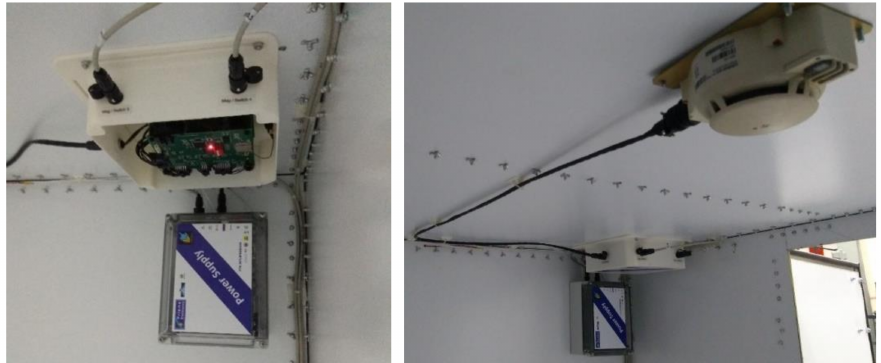
Figure 12. The INTELLICONT devices and the smoke detector installed inside the